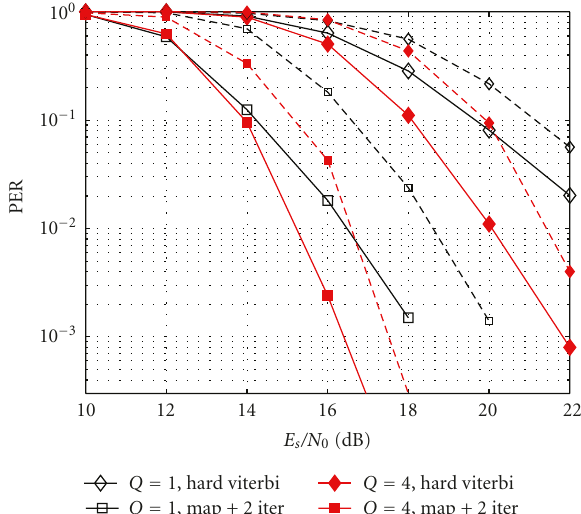
Figure 6: Configuration 1. PER with ideal channel estimation (solid lines) and imperfect channel estimation (dashed lines).